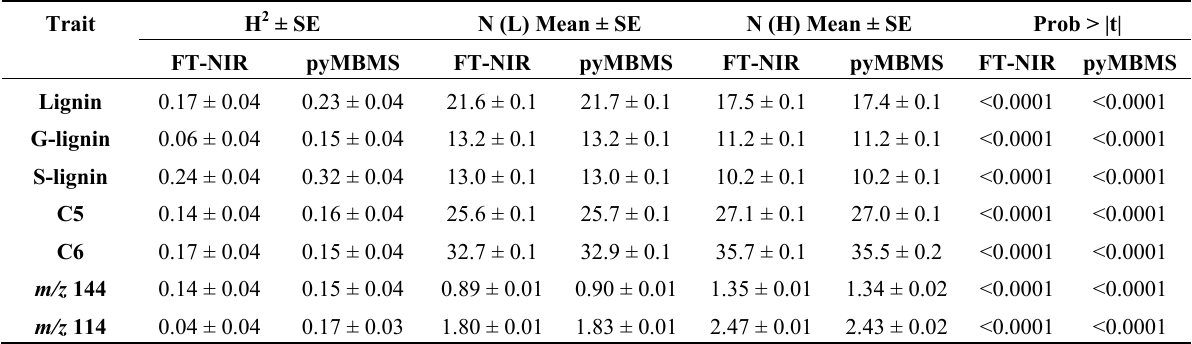
Table 2. Estimates of clonal repeatability and average trait value for seven wood chemistry phenotypes in two nitrogen treatments with pyMBMS and FT-NIR of 500 set.